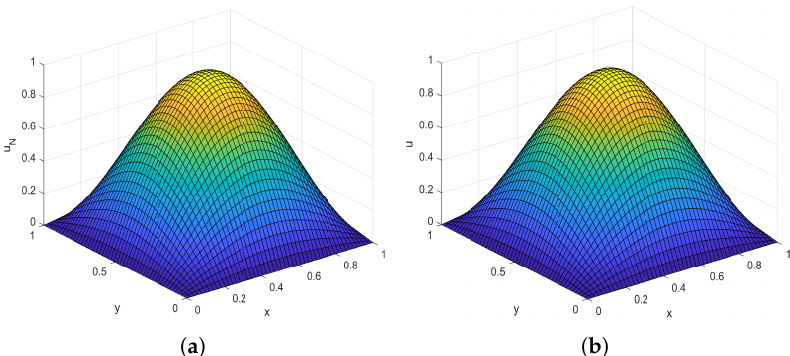
Figure 1. Numerical solution and exact solution for Case 1 at the final time t = 1 with α = 0.7, β = 0.8, θ = 0.2, τ = 1/320, h 1 = h 2 = 1/50. ( a ) Numerical solution. ( b ) Exact solution.